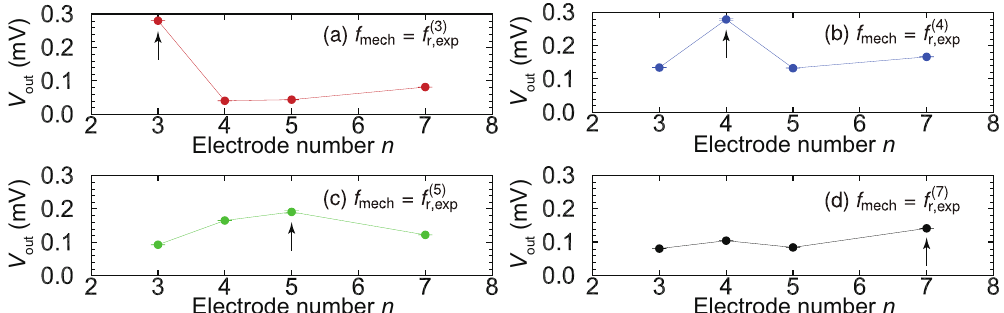
Figure 7. Electrical output V out plotted against electrode number n for various resonance frequencies: ( 3 ) = f ( 4 ) = f ( 5 ) = f ( 7 ) ( a ) f mech = f r,exp , ( b ) f mech r,exp , ( c ) f mech r,exp , ( d ) f mech r,exp . V out from the n th electrode ( n ) is maximized at f r,exp ( n =3, 4, 5, 7) and is applied as indicated by the black arrows.